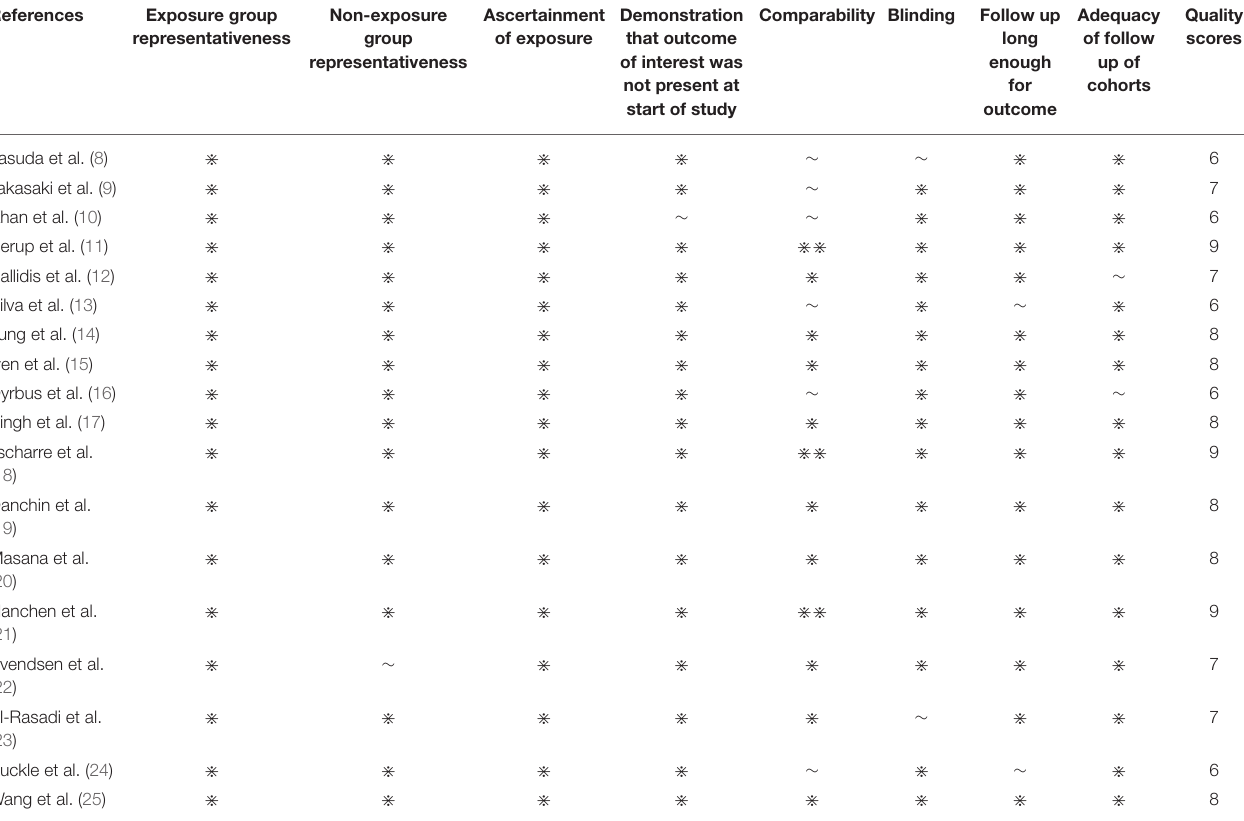
TABLE 2 | Methodological quality evaluation of the included